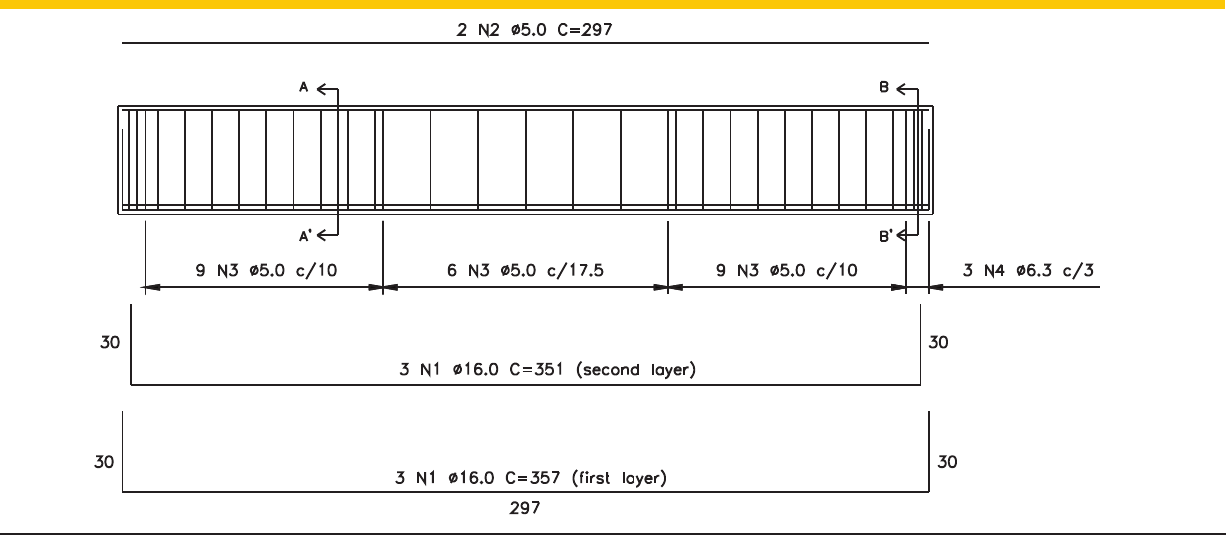
Figure 6 – Configuration of steel reinforcements of series I and series II